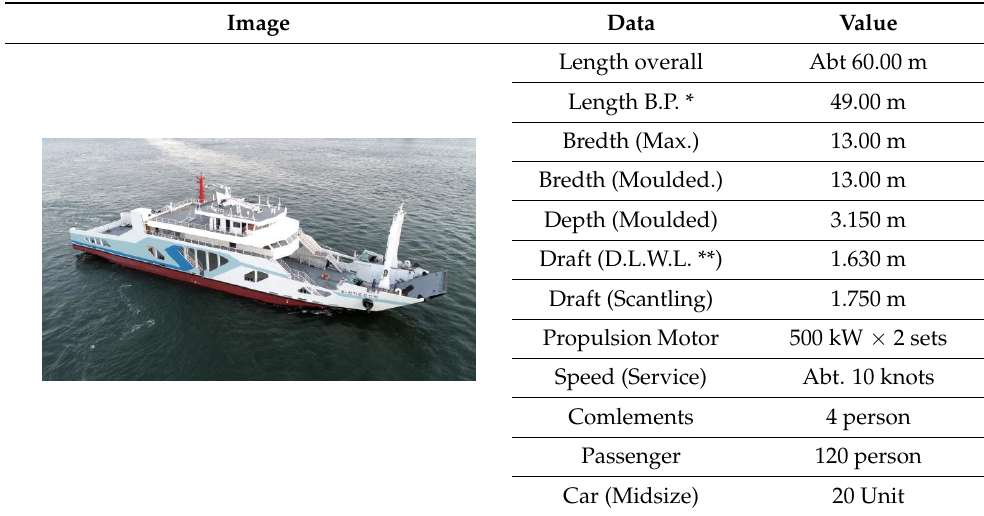
Table 3. Specifications of target small car ferry subject to the BSS